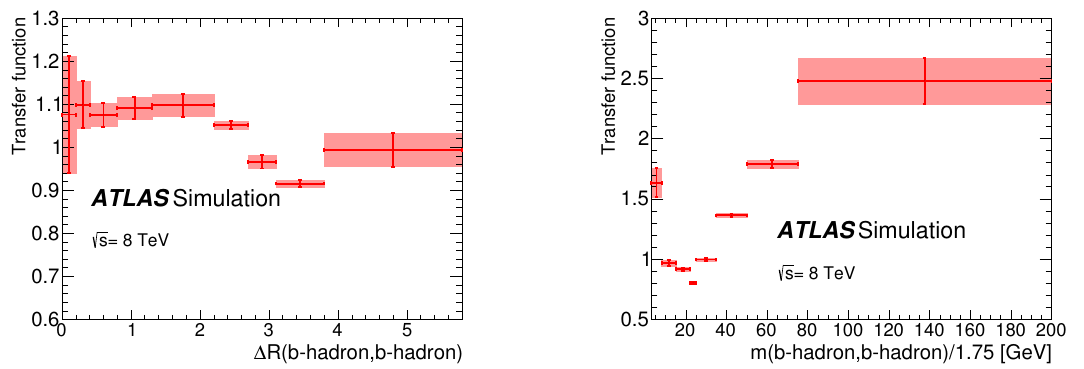
Figure 10 . The transfer functions and uncertainty envelopes for (cid:1) R ( b -hadron, b -hadron) (left) and m ( b -hadron, b -hadron), with the 1.75 scale factor applied (right). The resulting transfer functions for m ( b -hadron, b -hadron) and (cid:1) R ( b -hadron, b -hadron) are shown in (cid:12)gure 10. It can be seen that the transfer function is relatively constant in (cid:1) R ( b -hadron, b -hadron), but shows more structure in mass around the nearby (low mass) and back-to-back (higher mass) kinematic edges. The kinematic requirements on the b - hadrons result in no event populating the lowest (cid:1) R ( b -hadron, b -hadron) bin for the p < 20 GeV selection, and so the transfer function is not de(cid:12)ned in this one bin. The transfer functions are applied as a bin-by-bin multiplicative factor to two- b -hadron predictions from MadGraph5 aMC@NLO + Pythia8 and Sherpa , before these predic- tions are normalised to unit area. The uncertainty in the transfer functions is added in quadrature to any statistical uncertainty in the predictions from these event generators, and completely dominates those statistical